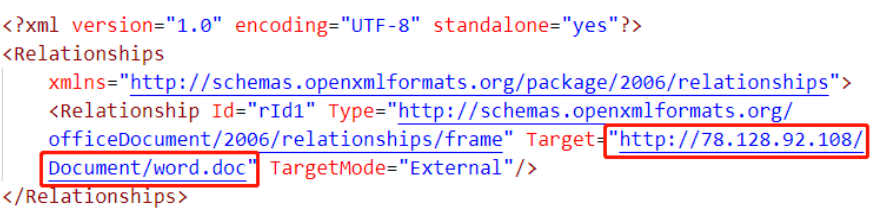
Figure 1. Example content of word/_rels/webSettings.xml.rels.